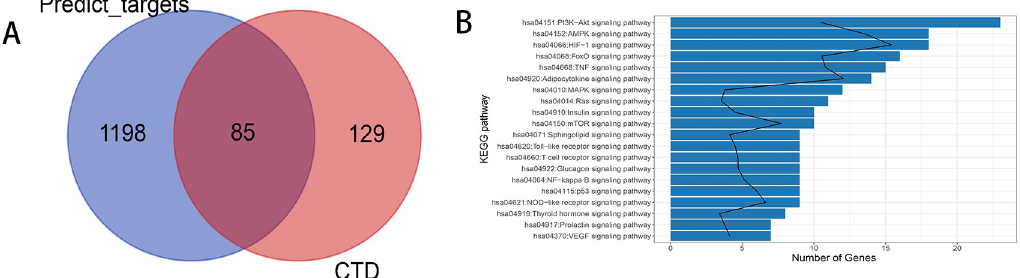
Fig 1. (A) Venn diagrams of Yishen capsules and cross-validation targets. Blue represents targets, pink represents genes relevant to DN with inference scores > 50 according to the Comparative Toxicogenomics Database, and red represents cross- validation targets (B) The top 20 pathways of the cross-validation targets. The bar represents the number of enriched genes, and the black line represents -log10 (p